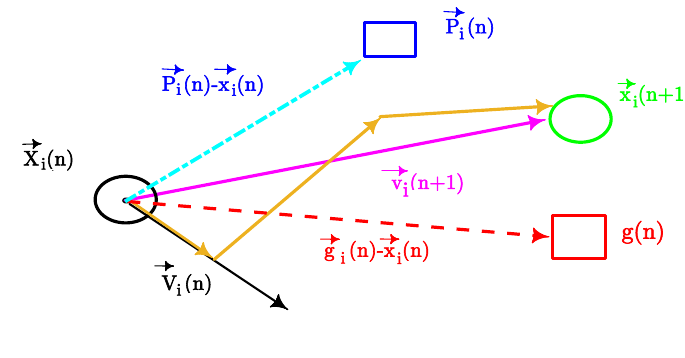
Figure 4. Mathematical model of